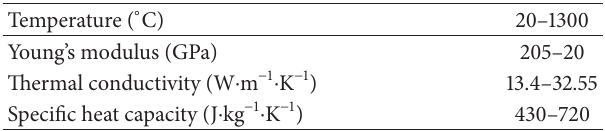
Figure 1: The geometry of IFW specimens (a) and meshed 2D axisymmetric model (b). Table 1: Properties of GH4169 superalloy used in simulations